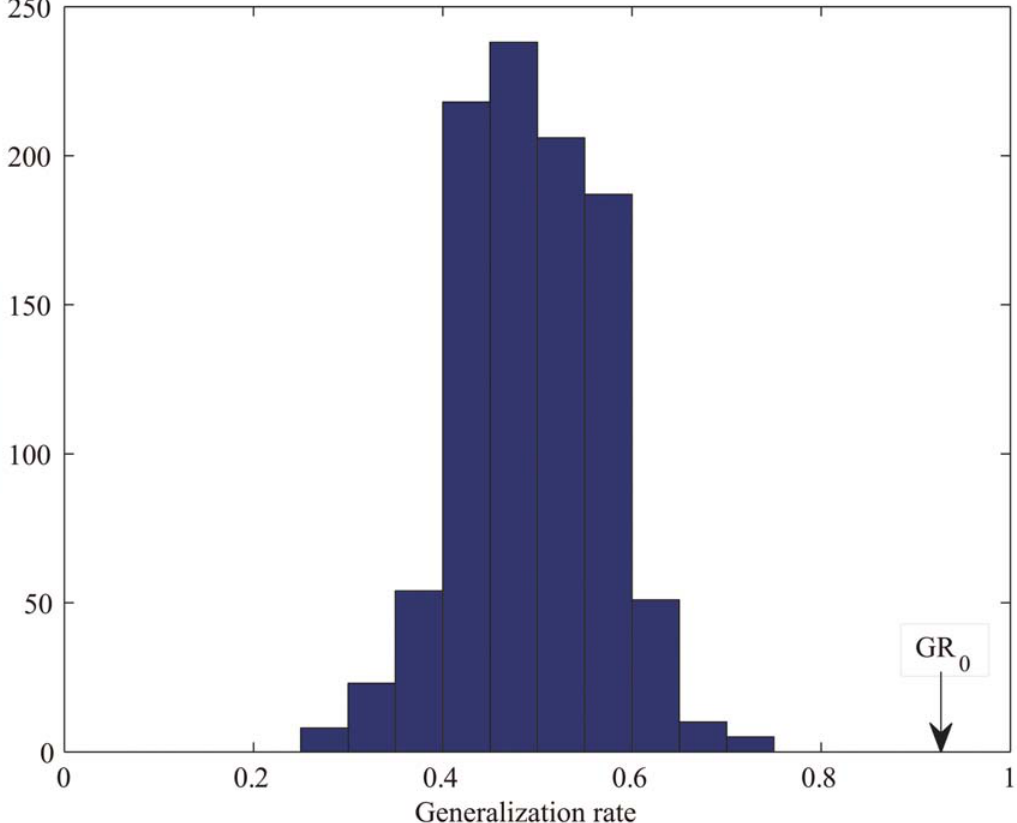
Fig 2. The permutation distribution of the generation rates (1,000 repetitions) when selecting the 150 most discriminating features: the x- and y- labels represent the generalization rate and occurrence number, respectively. GR 0 is the generation rate obtained using the real class labels.